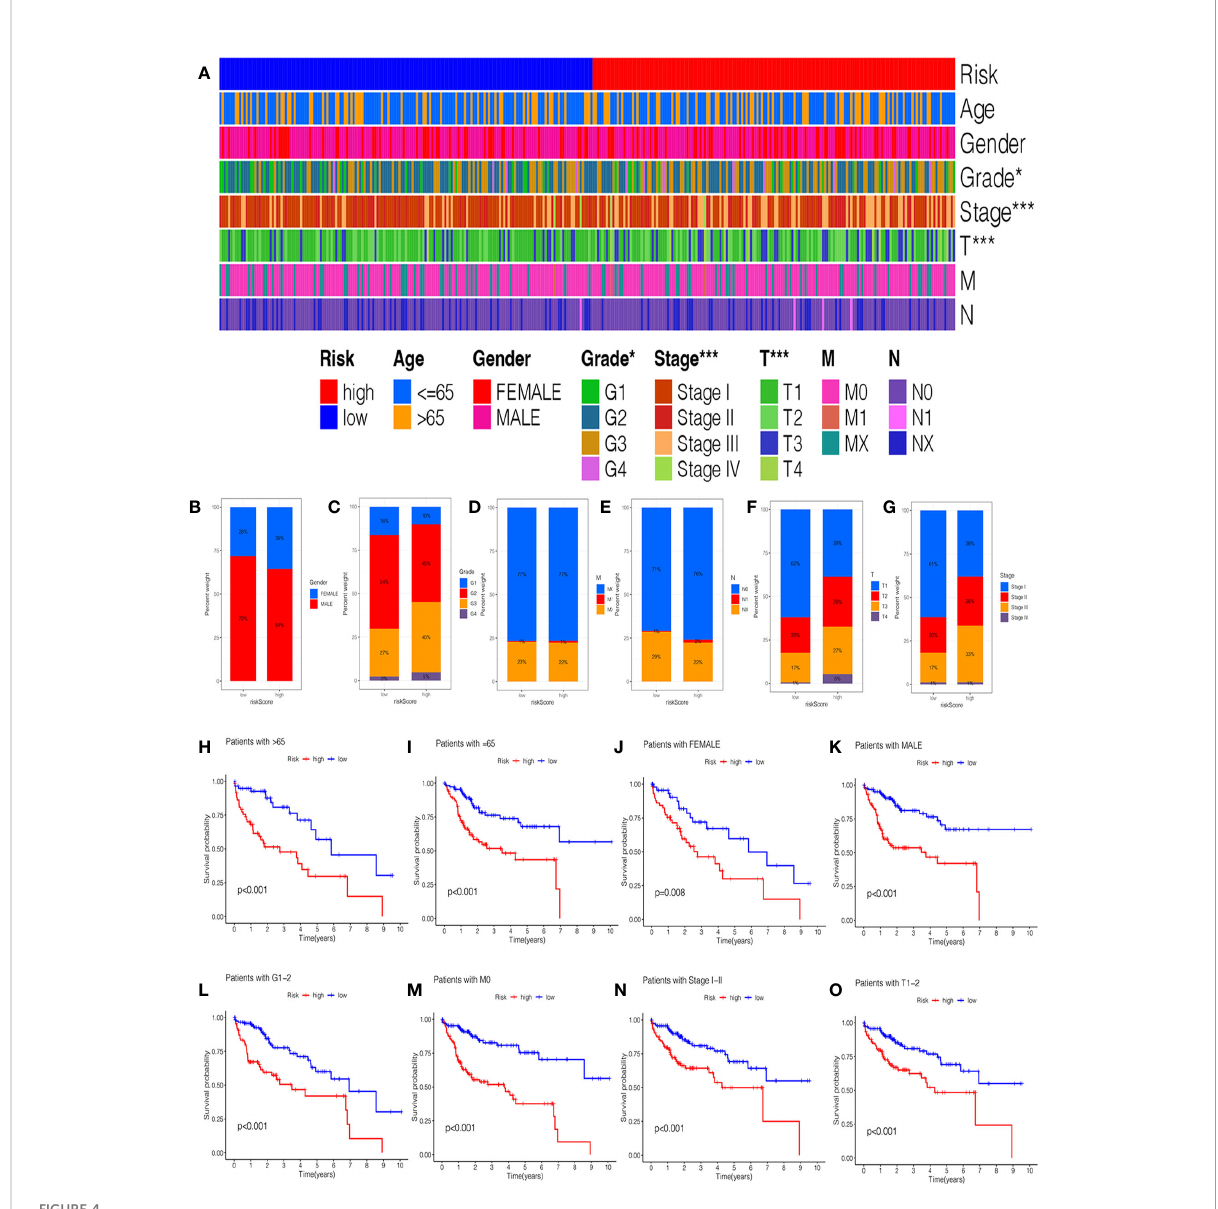
FIGURE 4 The correlation of clinicopathological features with the prognostic signature. (A) The heatmap analysis between clinicopathological characteristics and low- and high-risk groups. The proportion of different clinicopathological characteristics in low- and high-risk groups: (B) Gender. (C) Grade. (D) M stage. (E) N stage. (F) T stage. (G) stage. The K-M survival analysis of clinicopathological factors between low- and high-risk groups: (H) Age ≥ 65. (I) Age = 65. (J) Female. (K) Male. (L) Grade 1 – 2. (M) M0 stage. (N) Stage I-II. (O) T1 – 2